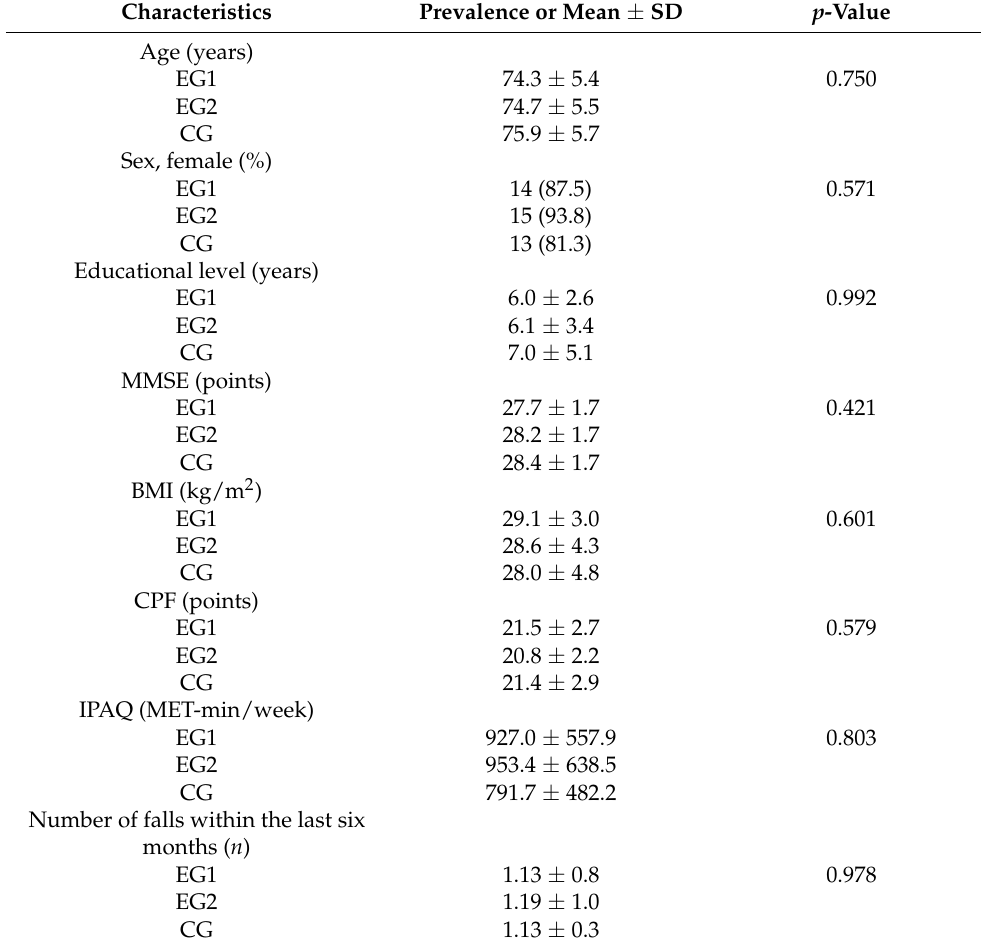
Table 1. General characteristics of the participants at